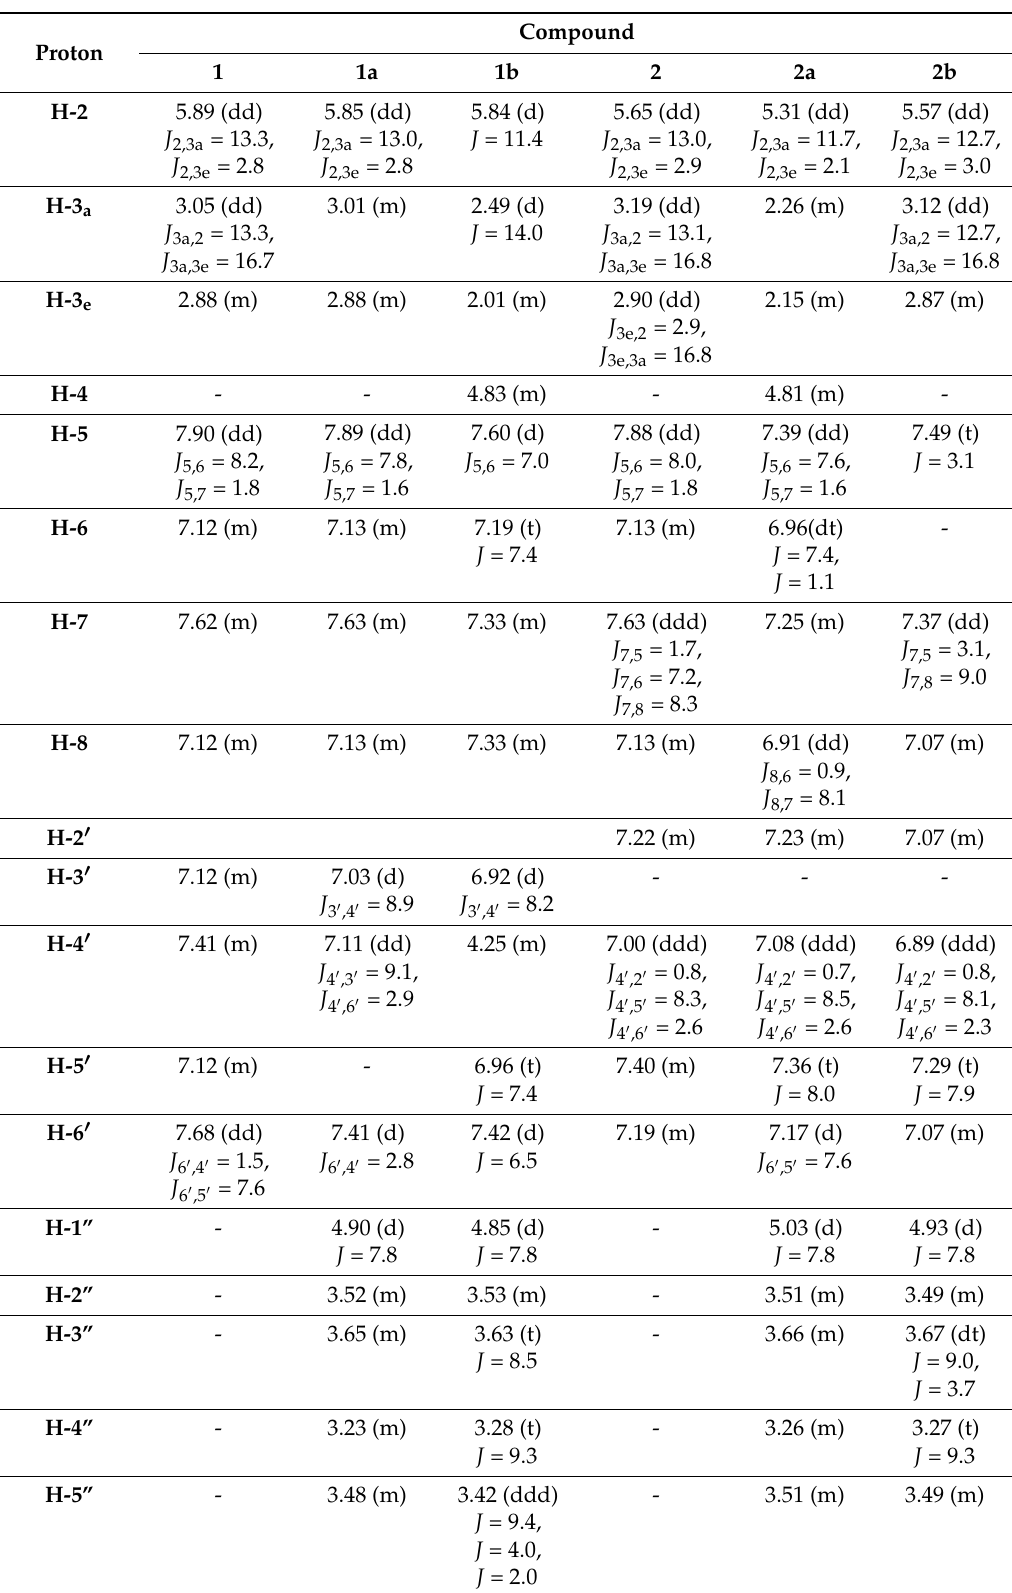
Table 1. The 1 H-NMR shifts ( δ ) (ppm) and coupling constants ( J H,H ) (Hz) of 2 (cid:48) -methoxyflavanone ( 1 ) and 3 (cid:48) -methoxyflavanone ( 2 ) and the products of their biotransformations ( 1a , 1b , 2a , 2b ) in Acetone-d 6 , 600 MHz (Supplementary